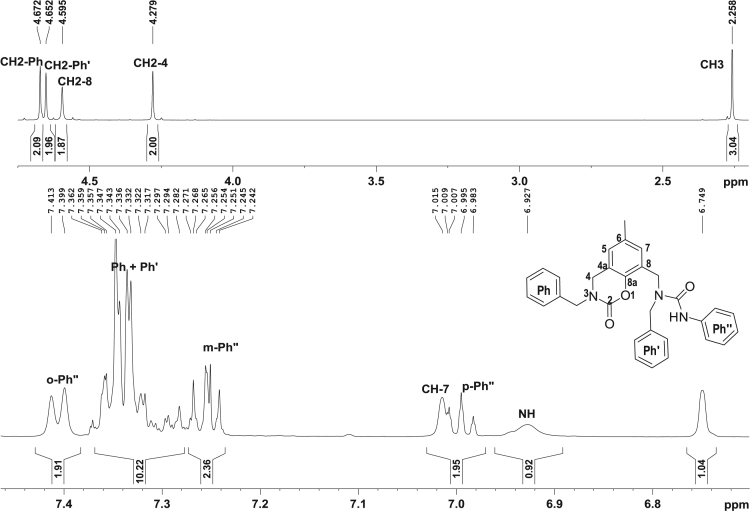
1H NMR spectrum of ligand S2.